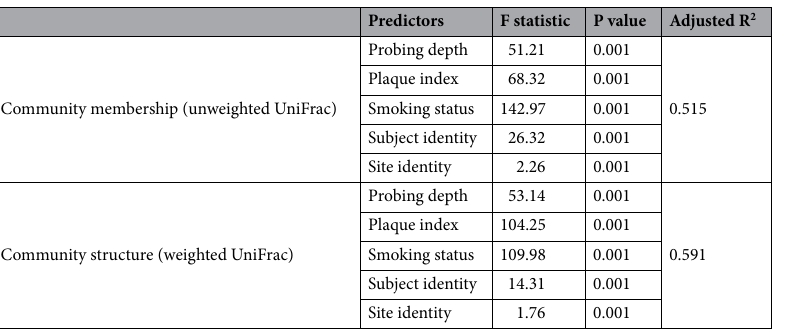
Table 2. Distance-based redundancy analysis (db-RDA) on UniFrac distances of subgingival microbiome samples. db-RDA was constrained by smoking status, probing depth, and subject identity. F statistics and p values were generated through ANOVA like permutation tests using 999